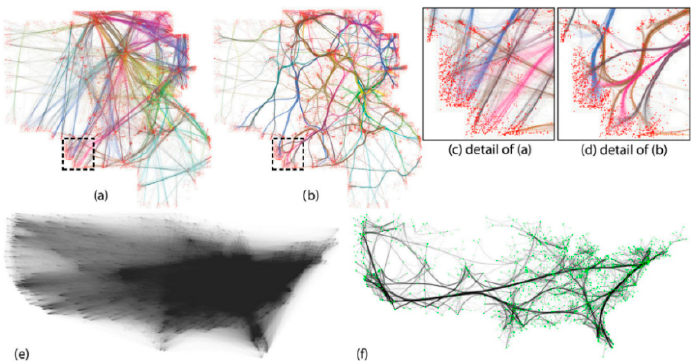
Figure 44. Bundled-trajectory visualization [119]: ( a , e ) unbundled trajectory sets; ( b ) the bundling of ( a ) with the SBEB method; ( f ) the bundling of ( e ) with the KDEEB method; and ( c , d ) close-up views of ( a , b ) (image courtesy of Hurter et al.).